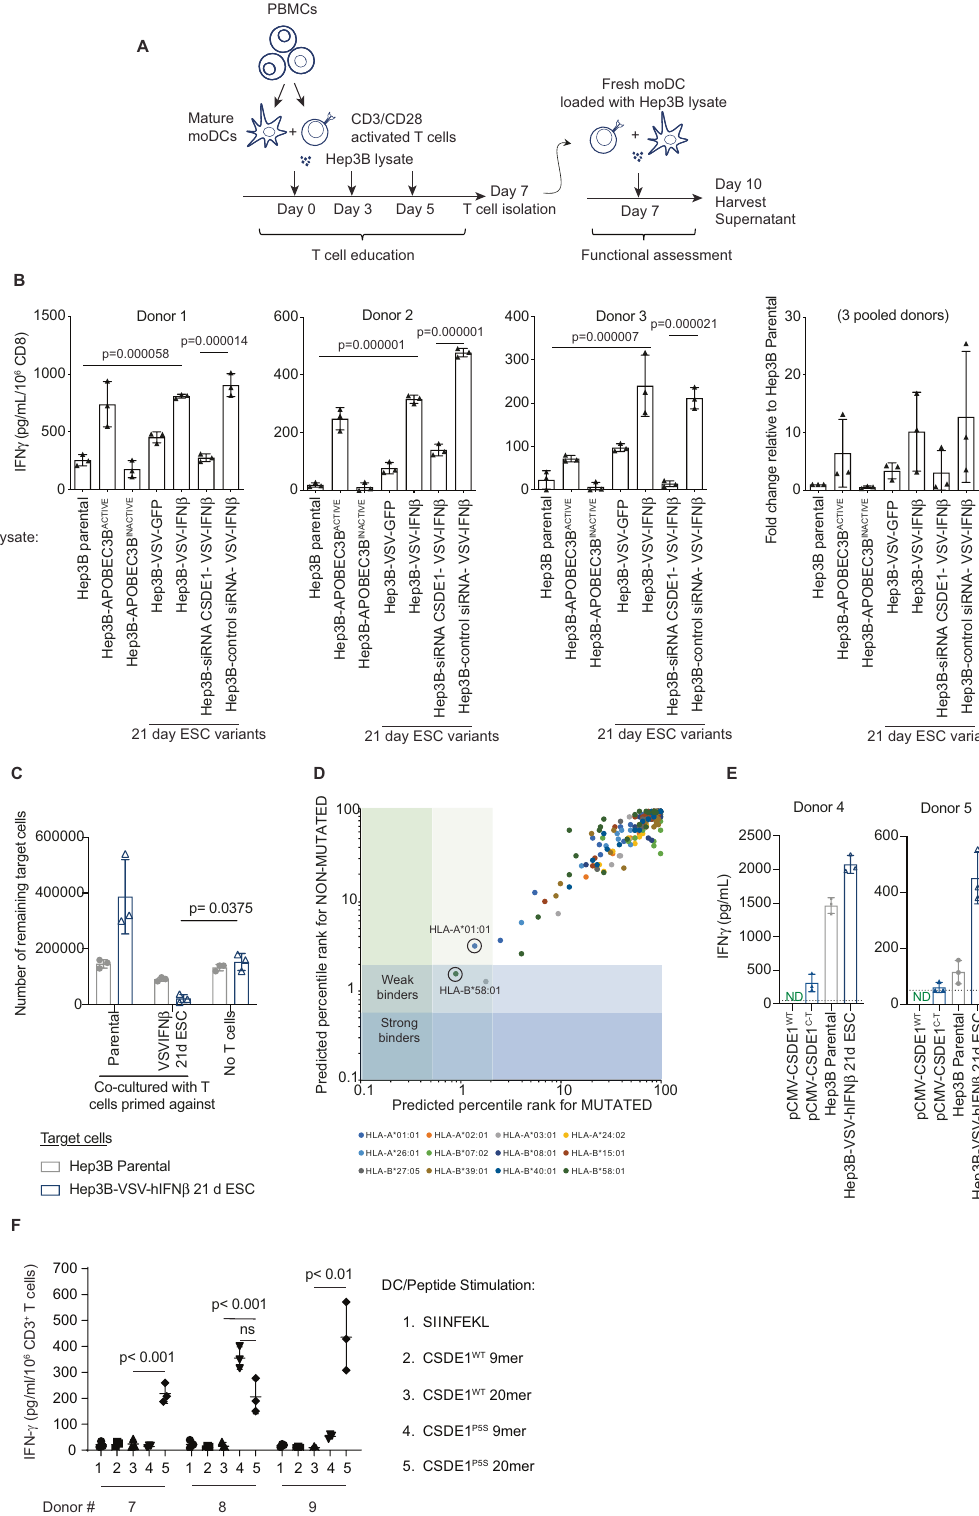
CSDE1 P5S may inhibit this disengagement, thereby signi fi cantly deregulating viral transcription, leading to decreased unicistronic M RNA (Fig. 3B), increased bicistronic P – M RNA (Fig. 3C), and loss of M protein (Fig. 3G). In this scenario, the complementary mutation of the viral IGR P/M C-U would allow